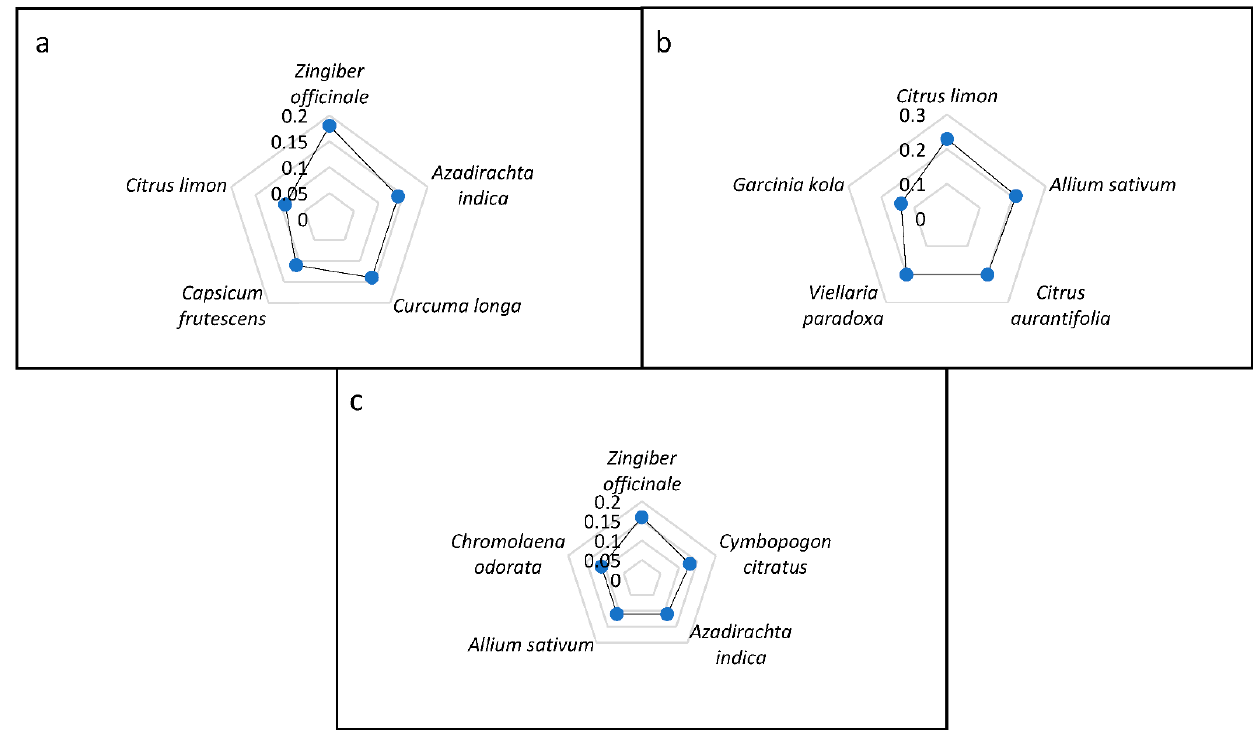
Figure 7. Relative frequency of citation of top five plant species used for the treatment of ( a ) COVID- 19, ( b ) cough, and ( c ) flu in Ogbomosho North and South Local Government Areas, Oyo State, Ni- geria.